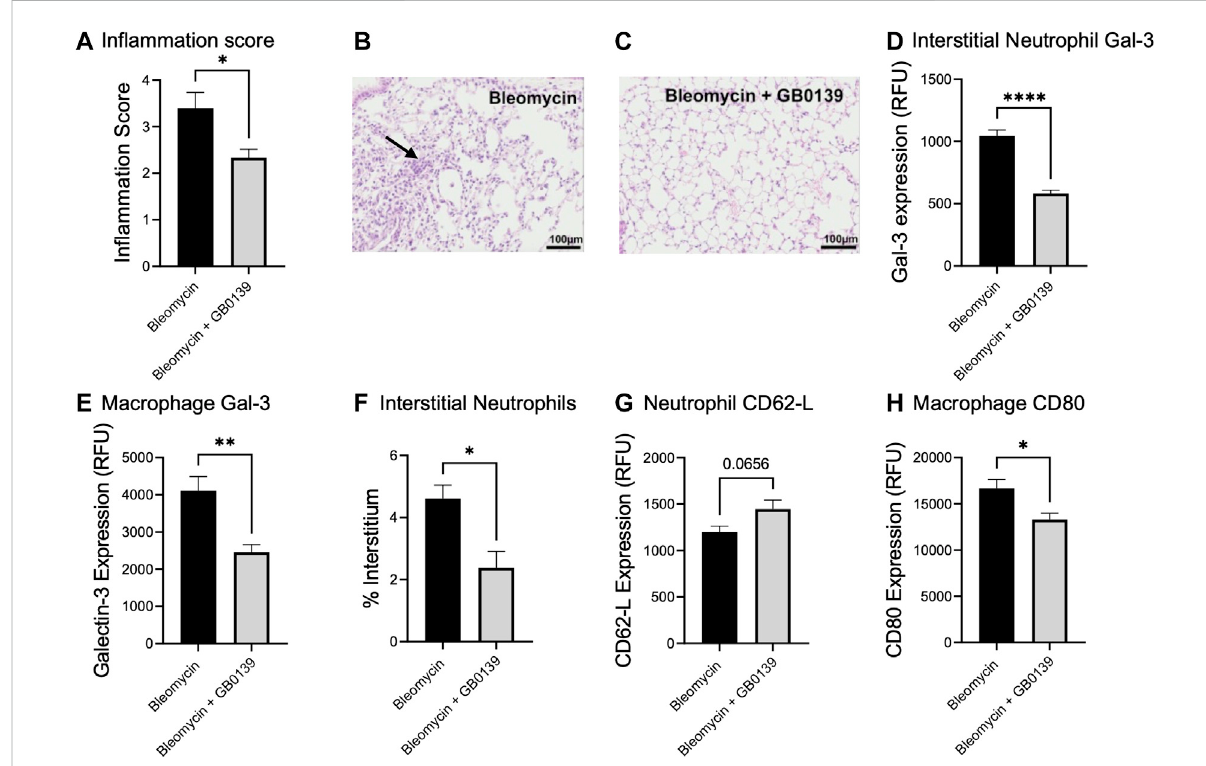
FIGURE 5 Effect of GB0139 on bleomycin-induced lung in fl ammation. 33 μ g bleomycin was administered i.t. with further administration of 30 μ g GB0139 every 24 h and lung tissue retrieved at day 3. (A – C) Histology in fl ammation score and representative H and E sections following administration of bleomycin with/without GB0139. Arrow indicates areas of pulmonary in fl ammation (alveolar membrane thickening, capillary congestion and alveolar neutrophil in fi ltration). (D) Gal-3 expression on interstitial neutrophils. (E) Gal-3 expression on macrophages. (F) Interstitial neutrophil accumulation. (G) Expression of CD62L on neutrophils. (H) Expression of the M1 marker, CD80 on macrophages. Data represented as mean ± SEM. Analysed via Student ’ s t-test (n = 5, * p < 0.05, ** p < 0.01, *** p < 0.001, **** p < 0.0001). Images taken at ×200 magni fi cation. E = eosin; H = haematoxylin; h = hours; i.t. = intra-tracheal; RFU = relative fl uorescence units; SEM = standard error of the